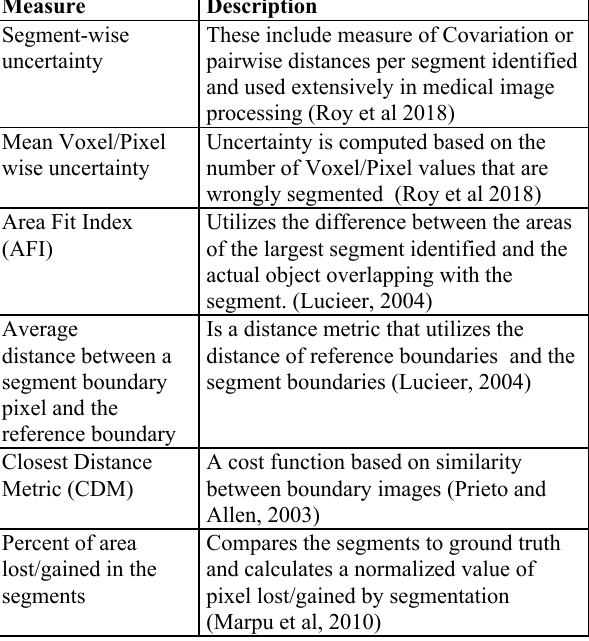
Table 1. Uncertainty measures for segmentation